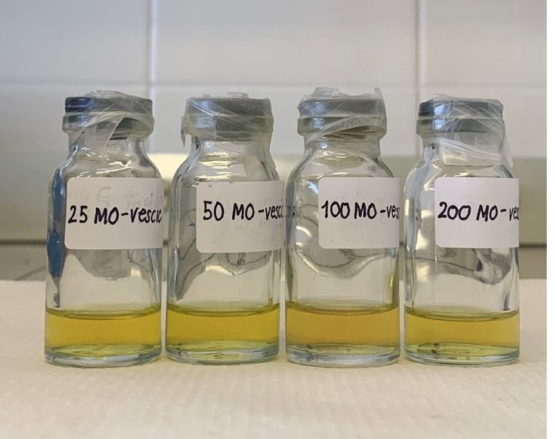
Figure 1. Representative images of the different dispersions of vesicles loading quercetin and increasing amounts of mint oil.